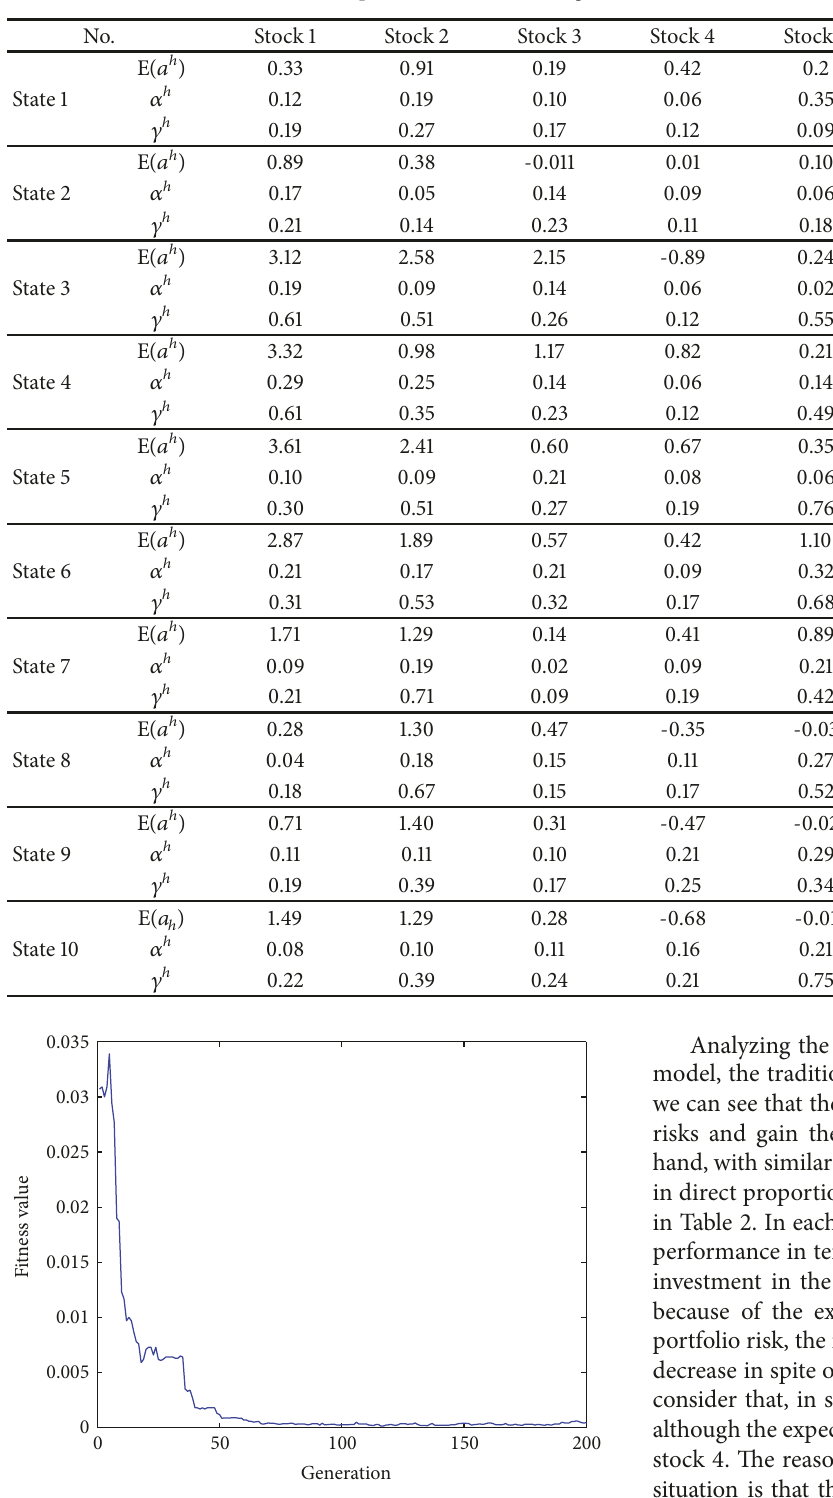
Figure 3: The average convergent speed of IHYE algorithm under each